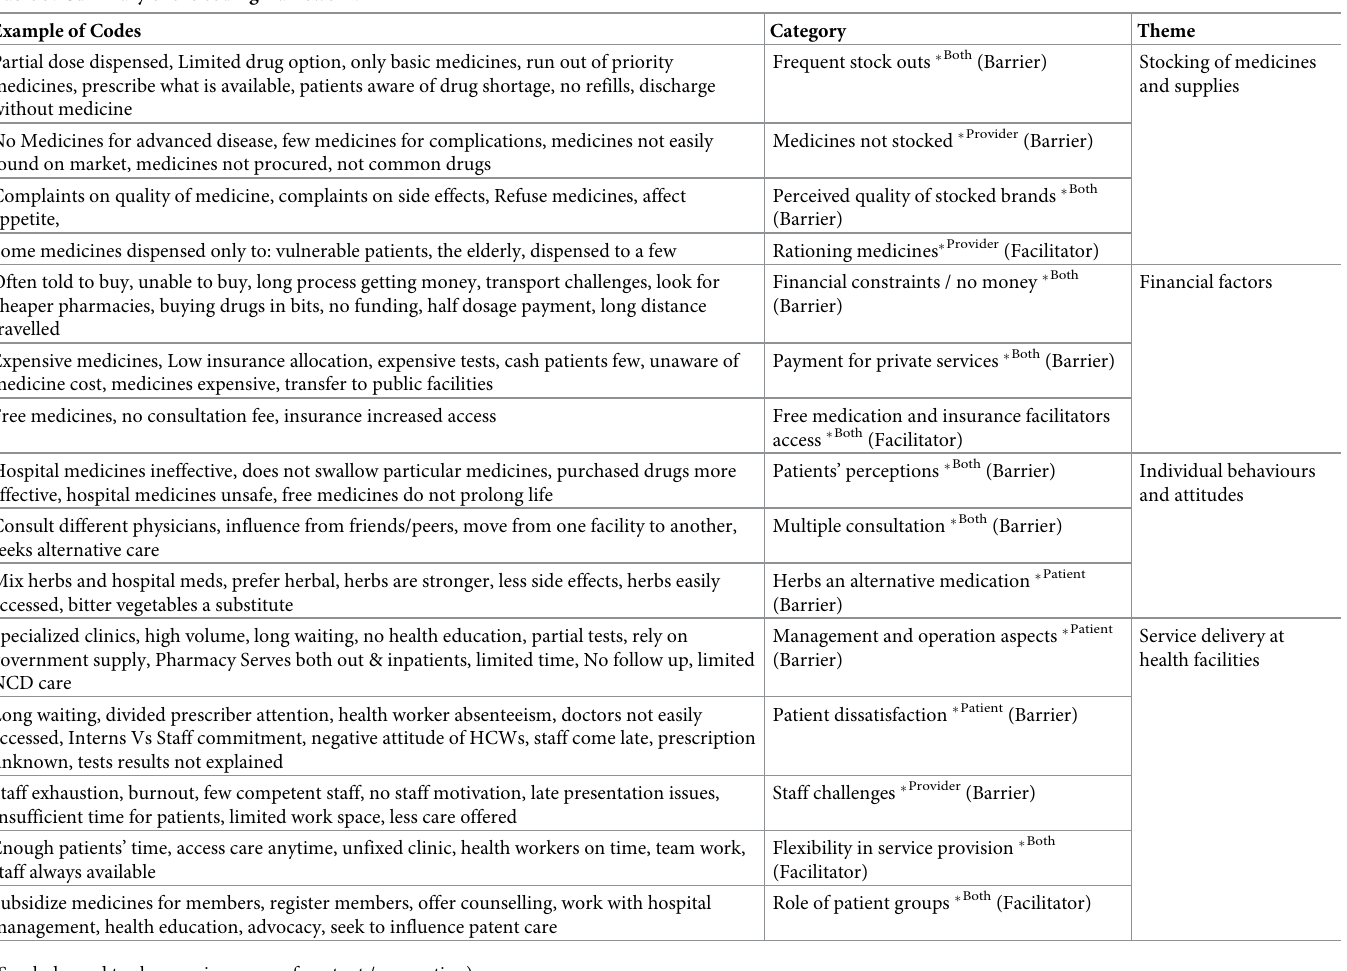
Table 3. Summary of the coding